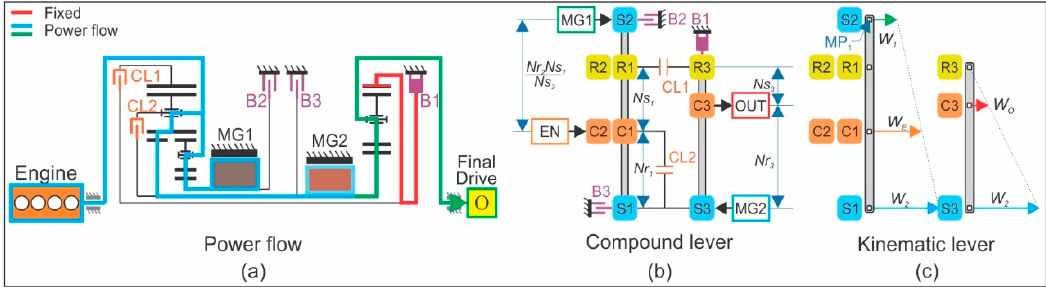
Figure 18. Input-split mode.